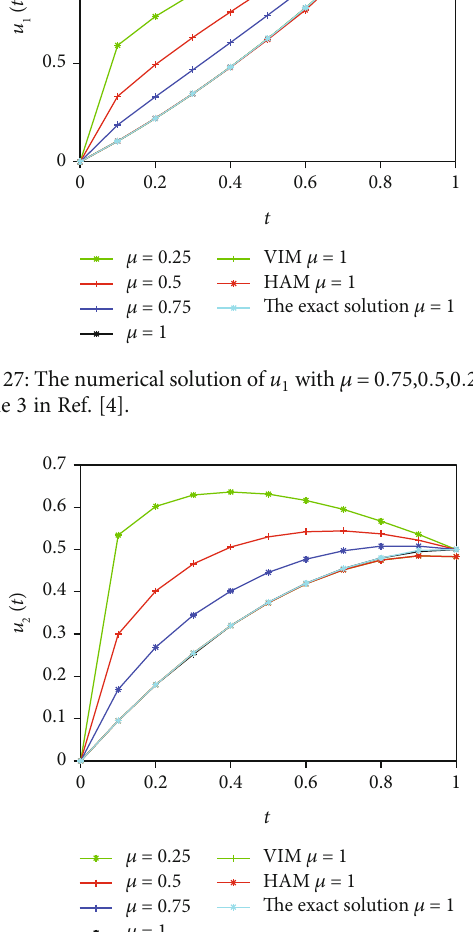
μ = 0 : 75,0 : 5,0 : 25,1 for 2 with